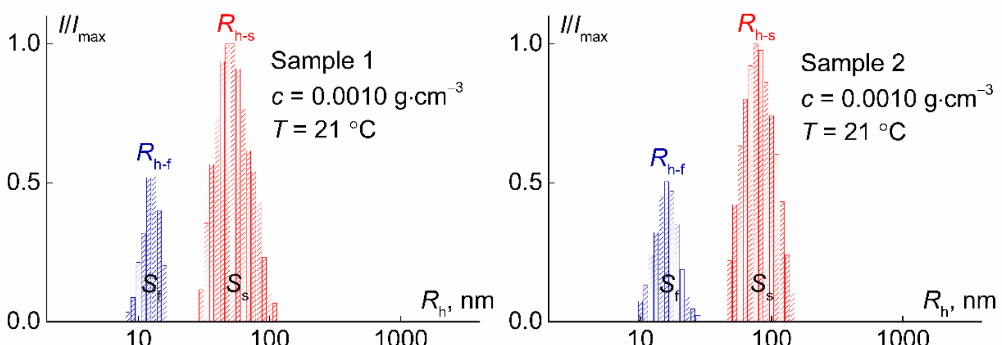
Figure 1. The dependences of relative intensity I / I max of scattered light on the hydrodynamic radius R h of scattering species for PDMS- g -PiPrOx solutions. I max is the maximum value of light scattering intensity I for a given